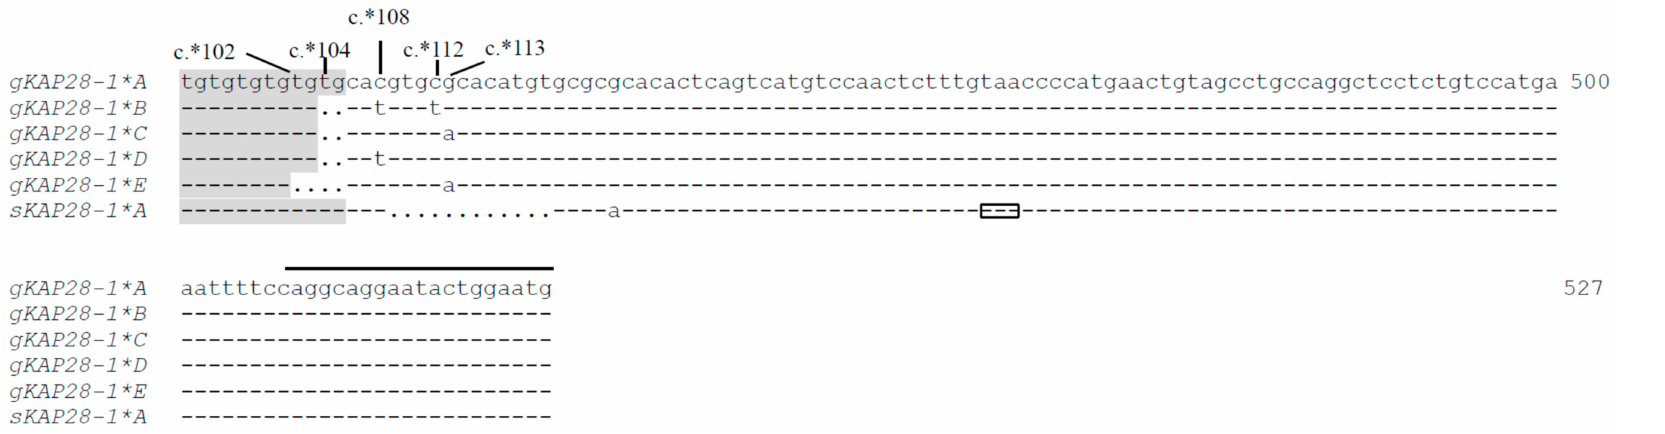
Figure 4. Sequence alignment of caprine KRTAP28-1 variants A - E along with ovine KRTAP28-1 variant A (Bai et al., 2019). The primer binding regions are designated with horizontal lines. A prefix “g” and “s” represents sequences from goat and sheep, respectively. Dashes indicate nucleotide identical to the caprine KRTAP28-1 A variant sequence, while dots have been introduced to improve the alignment. Nucleotides in the coding region of caprine KRTAP28-1 are shown in uppercase, while those outside the coding region of caprine KRTAP28-1 are in lowercase. Eleven nucleotide substitutions and a 2 (or 4)-bp deletion identified in caprine KRTAP28-1 are marked above the sequences, with the non-synonymous substitutions also indicated. The putative start codon (ATG) and stop codons (TAA) are boxed. The numbering of nucleotides and amino acids are in accordance with the guidelines at HGVS nomenclature (http: // varnomen.hgvs.org / ). The TG dinucleotide non-coding repeat region is